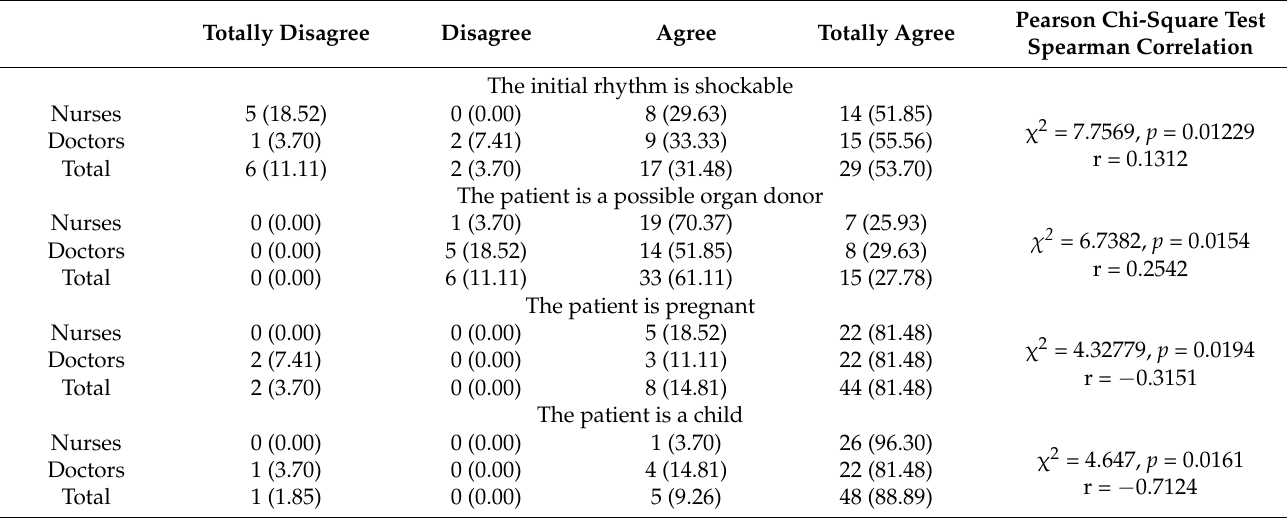
Table 4. Factors influencing the perception of the adequacy of a